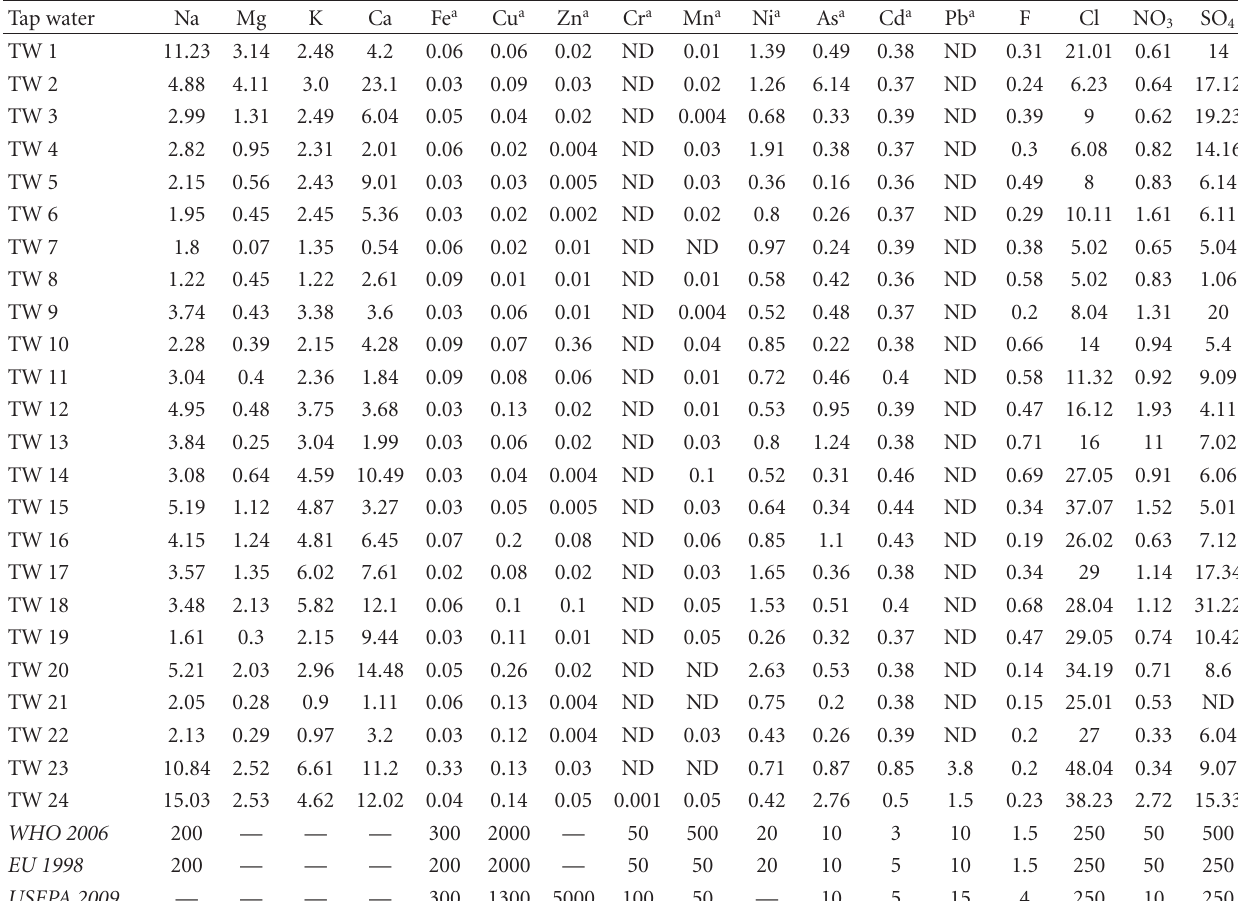
Table 4: Mineral concentrations in tap water (TW) samples and the standard limits recommended by international